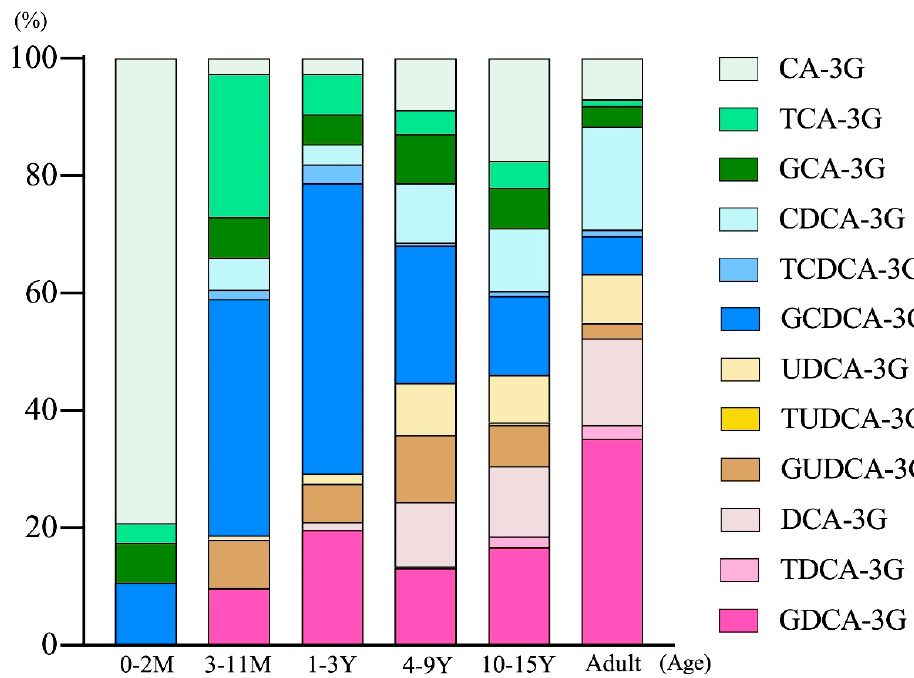
Figure 1. Changes in urinary glucuronidated bile acids across age groups. Primary bile acids, CA-3G and CDCA-3G, were detected at 0–2 months, with CDCA-3G levels increasing after 3 months of age to become the predominant bile acid. Secondary bile acids, UDCA-3G and DCA-3G, were also observed after 3 months of age. GLCA-3G, TLCA-3G, LCA-3G, HCA-3G, and HDCA-3G were not detected in this study. Abbreviations are defined in Supplemental Table S1.